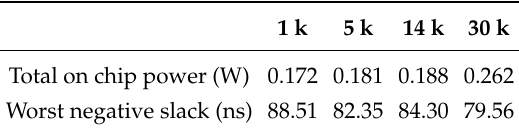
Table 10. Power consumption and the worst negative slack.